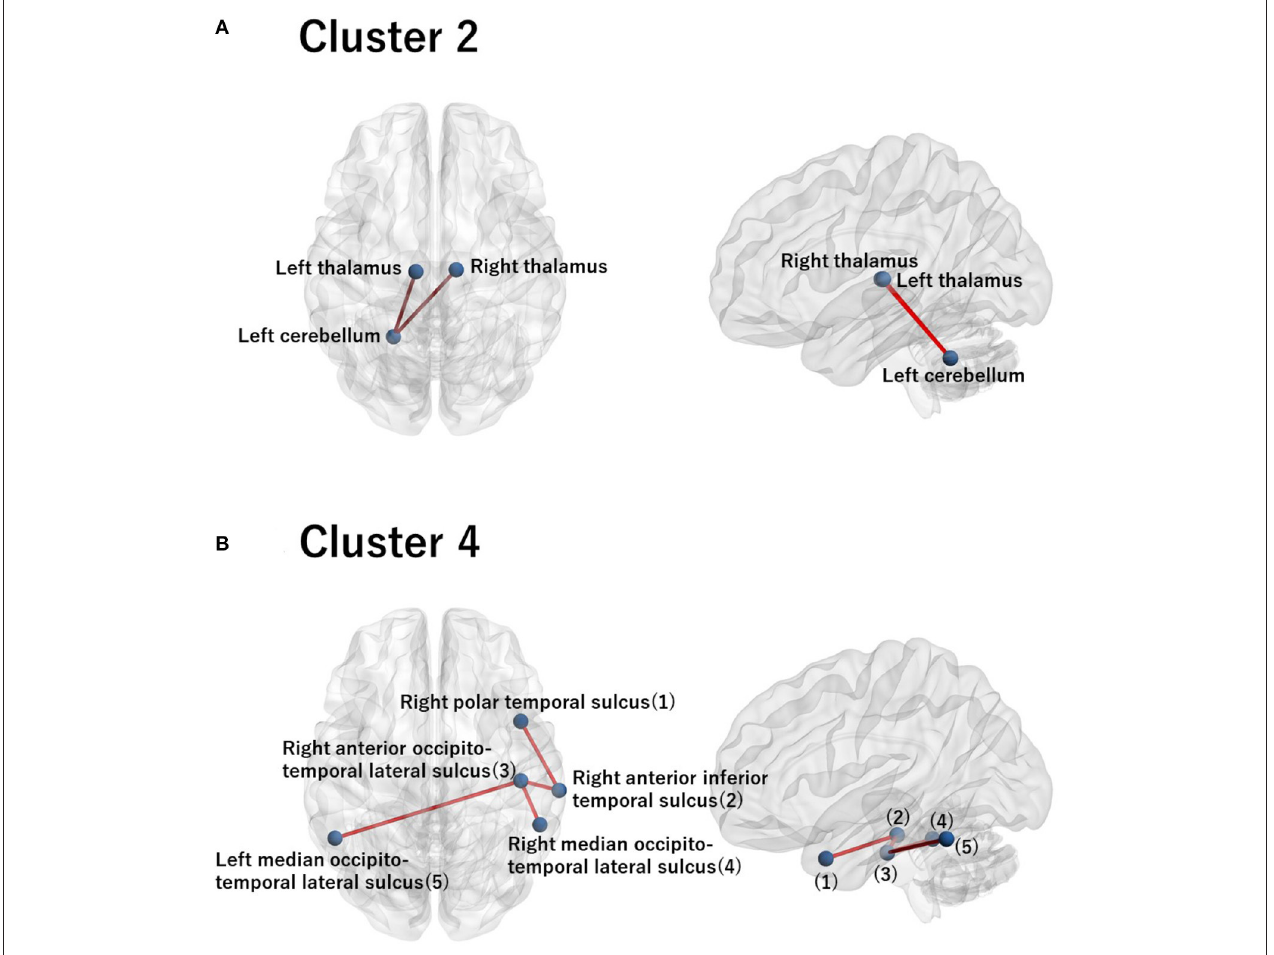
FIGURE 5 | Visualization of the commonly important FC for cluster 2 (A) and for cluster 4 (B) . (A) The commonly important FC that discriminates cluster 2 against the remainder of the clusters with the criterion Cohen’s d > 0.8: right thalamus − left cerebellum − left thalamus. (B) The commonly important FC that discriminates cluster 4 against the remainder of the clusters with the criterion Cohen’s d > 0.8: right polar temporal sulcus − right anterior inferior temporal sulcus − right anterior occipito-temporal lateral sulcus − (left and right) median occipito-temporal lateral sulcus. The numbering in the sagittal image denotes the corresponding ROI names in the axial image. Note that there is no commonly important FC for clusters 1 and 3 with the criterion Cohen’s d > 0.8. Hence, we did not visualize brain images for these